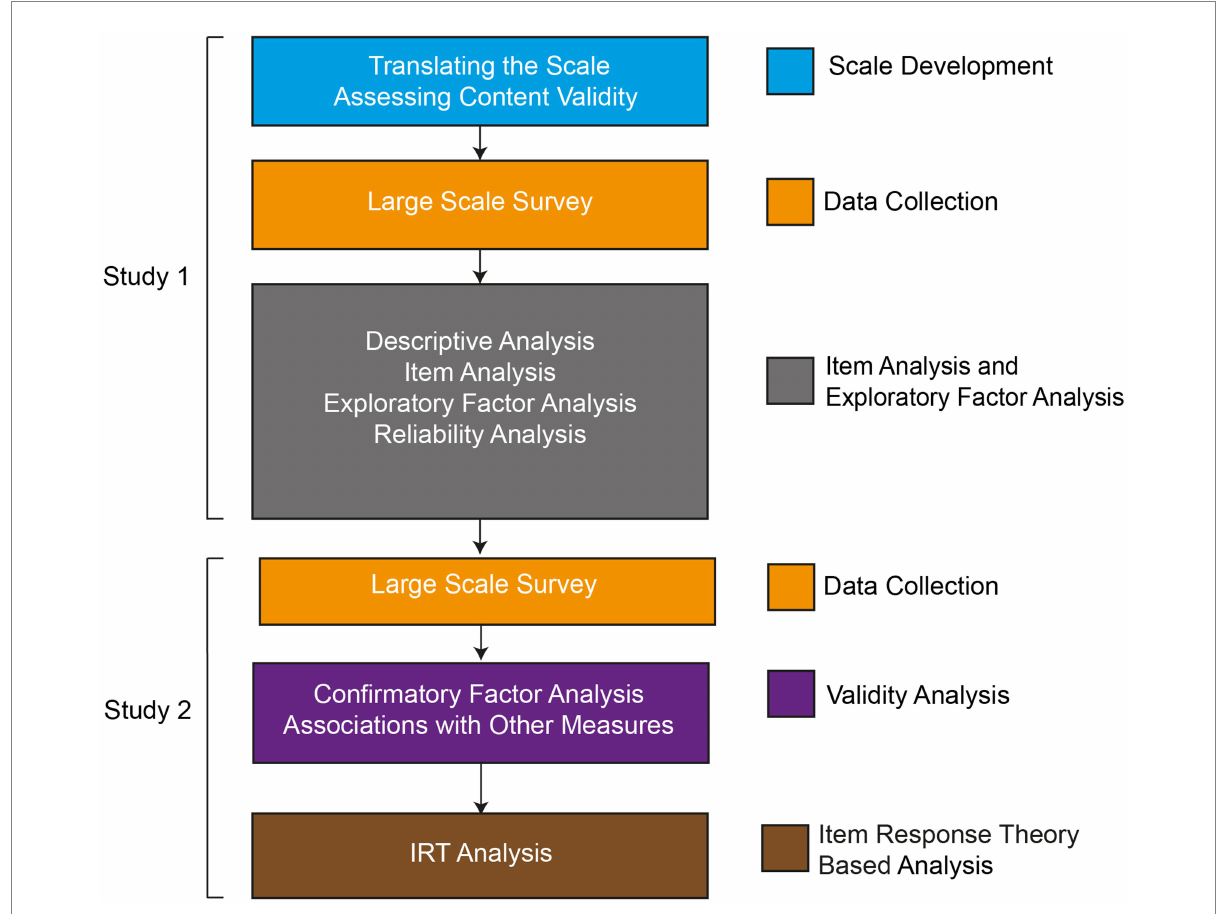
FIGURE 1 Flow chart of translation and psychometric evaluation of Bangla Rotter’s I-E